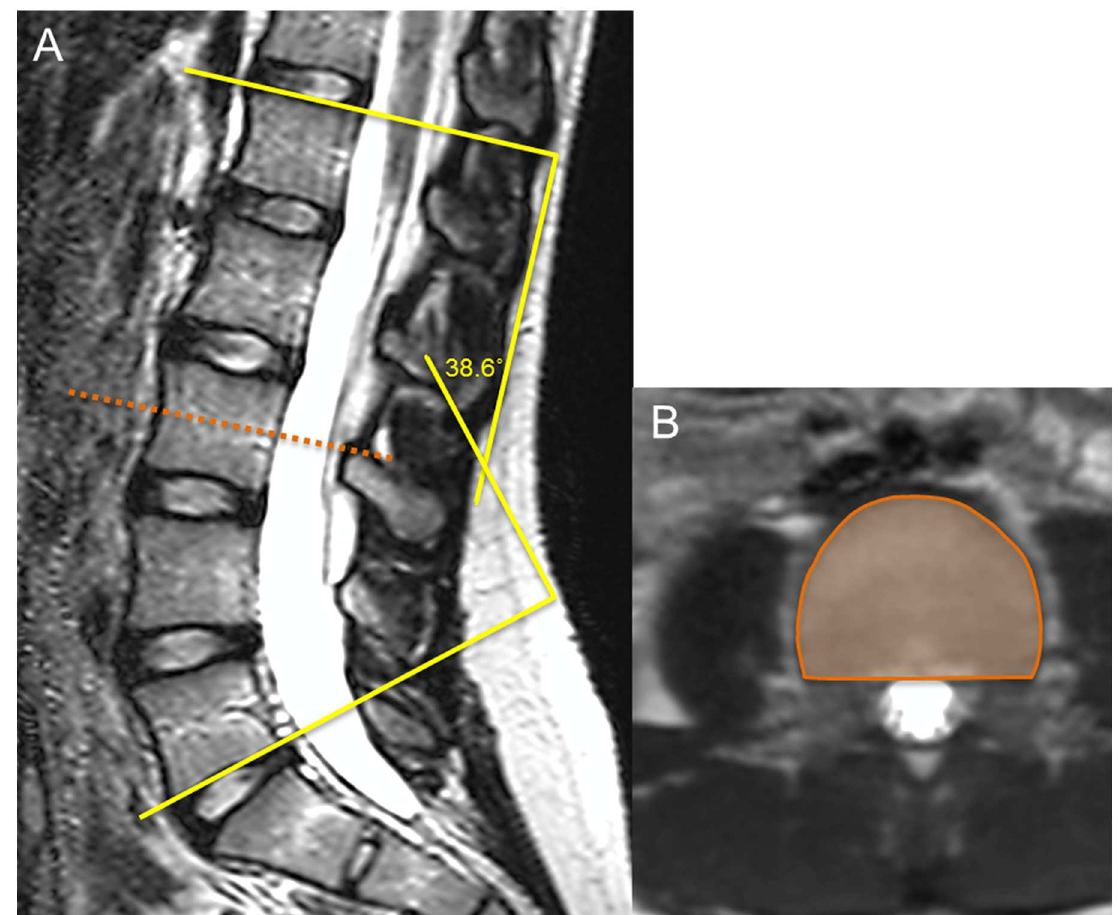
Fig 1. MRI images of the lumbar spine in a 13-year-old girl. (A) Coned-down sagittal image of the lumbar spine showingthe degreeof lumbarlordosis measuredas the angle betweenthe superiorendplateof L1 and the inferior endplate of L5. (B) Axial image outliningthe measurement of vertebral CSA at the third lumbar